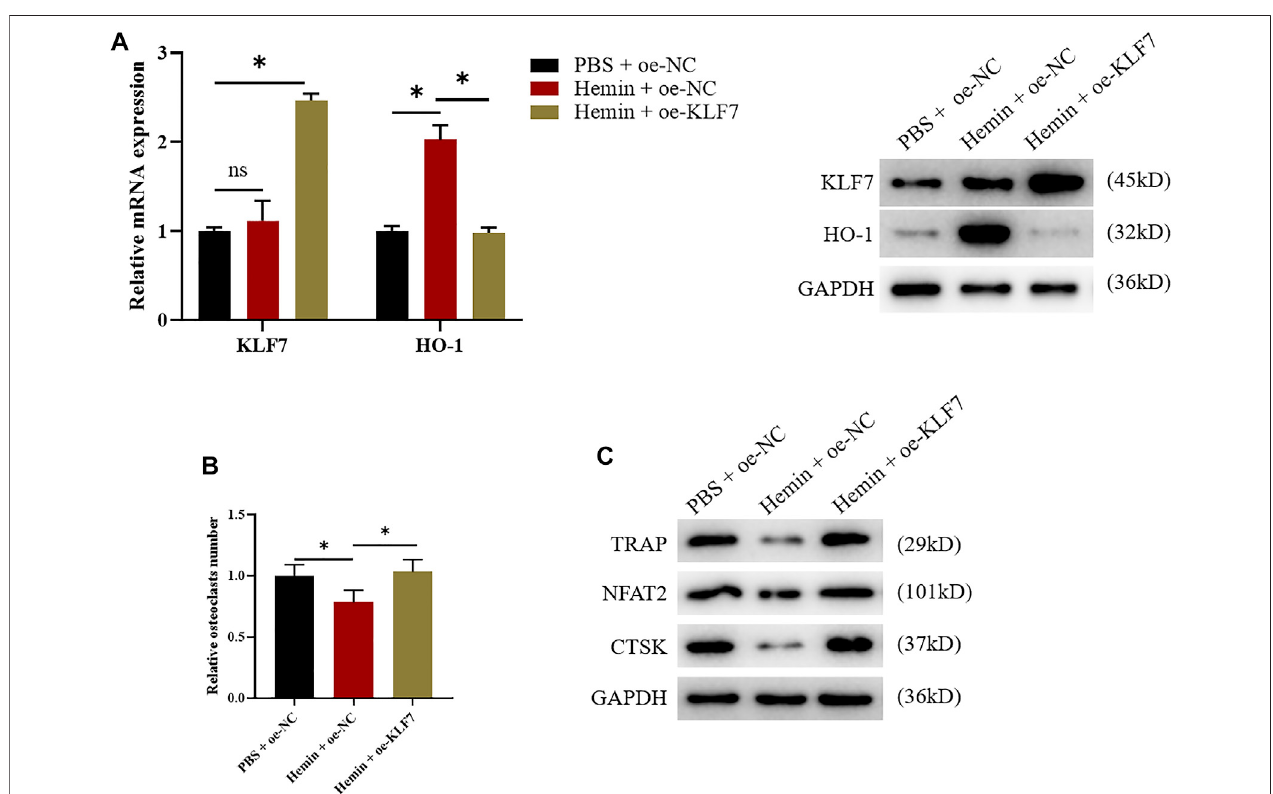
FIGURE 4 | KLF7 promotes osteoclast differentiation by suppressing HO-1 expression. (A) qPCR and western blot results showed changes of KLF7 and HO-1 expressionsafter hemin treatment and KLF7 overexpression. (B) TRAPstainingshowed osteoclast differentiation regulated by HO-1 and KLF7. (C) Expression levels of osteoclast markers measured by western blot assay. * p <